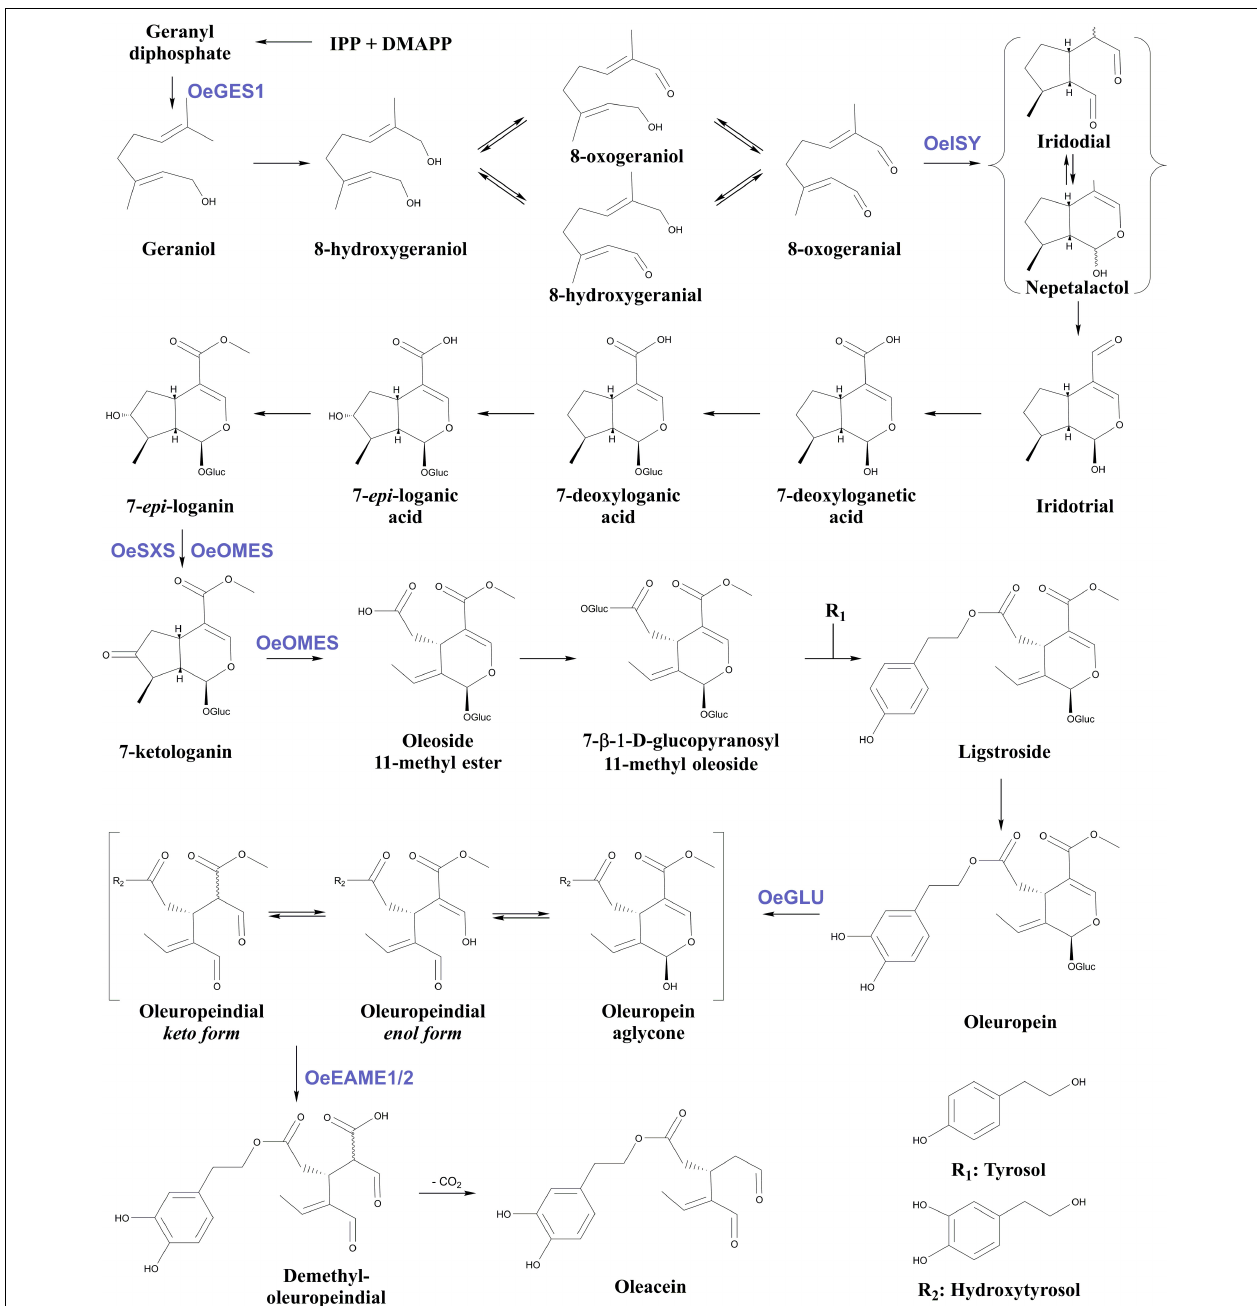
FIGURE 1 | Proposed biosynthetic pathway of oleuropein and oleacein in Oleaceae. Characterized enzymes of the pathway as referred in the literature (Obied et al., 2008; Vezzaro et al., 2012; Koudounas et al., 2015; Alagna et al., 2016; Volk et al., 2019; Rodríguez-López et al., 2021). IPP, isopentenyl diphosphate; DMAPP, Dimethylallyl diphosphate; Glu, glucose; OeGES1, geraniol synthase; OeISY, iridoid synthase; OeOMES, oleoside methyl ester synthase; OeSXS, secoxyloganin synthase; OeGLU, oleuropein β -glucosidase; OeEAME1/2, elenolic acid methylesterase 1 and